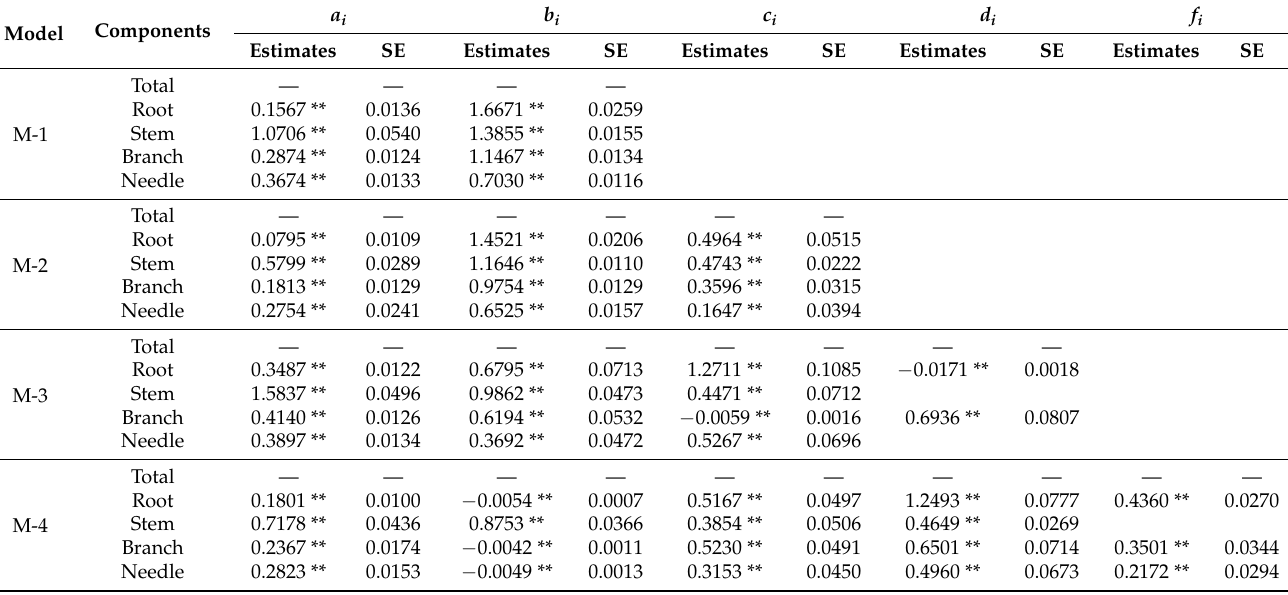
Table 2. Parameter estimates and standard errors (SE) of stand-level biomass